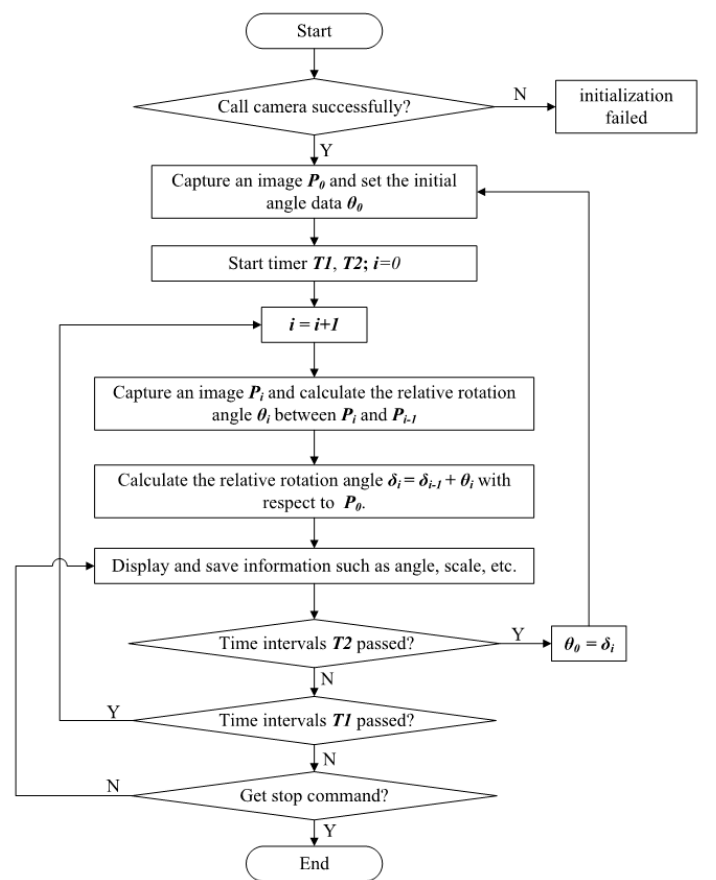
Figure 10. Work flow chart of the system.